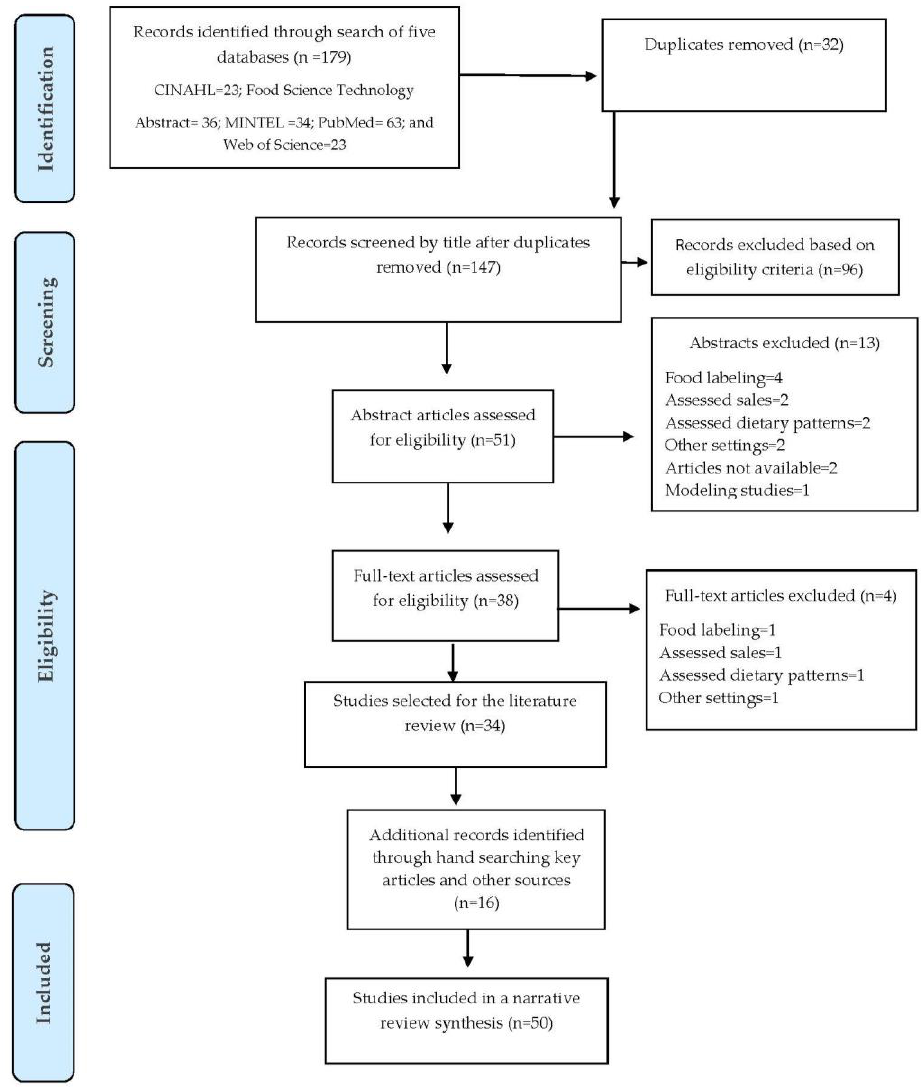
Figure 1. Preferred Reporting Items for Systematic Reviews and Meta-Analysis (PRISMA) flow